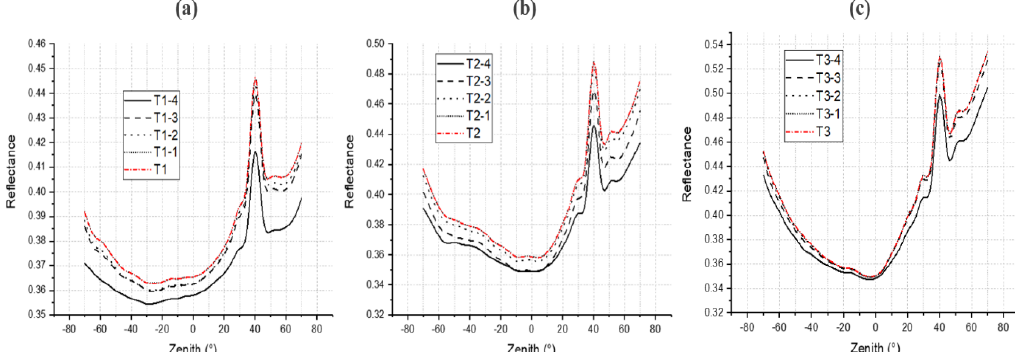
Figure 15. Reflectance at the wavelength 850 nm for different zenith angles, ( a ) first stage, ( b ) second stage, and ( c ) last stage.